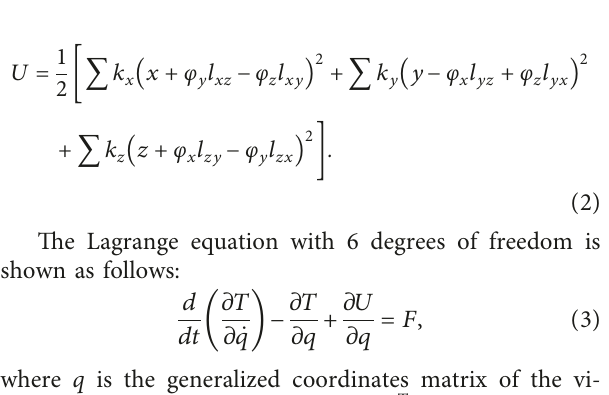
Figure 1: Schematic diagram of the ZS2560 linear vibrating